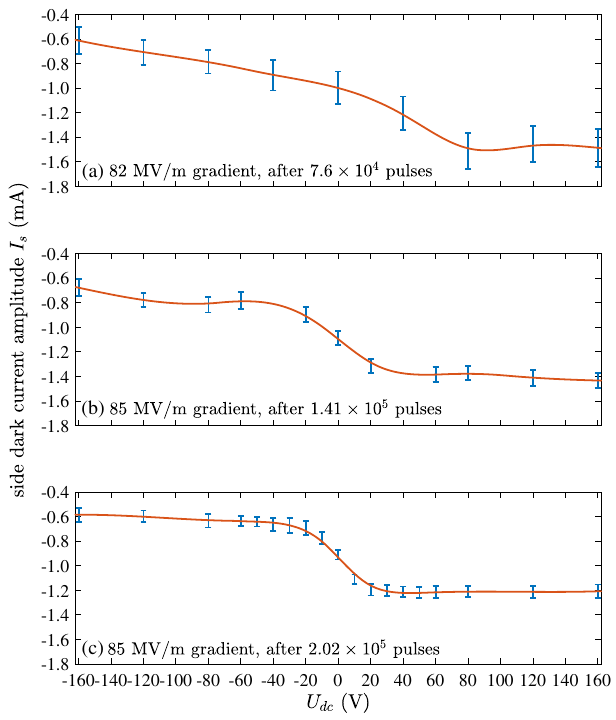
FIG. 15. Measurement results and the spline fitting (visual aid) of the side dark current amplitude under different dc bias voltages applied on the side dark current monitor, (a) after 7 . 6 × 10 4 pulses at 82 MV = m gradient; (b) after 1 . 41 × 10 5 pulses at 85 MV = m gradient; (c) after 2 . 02 × 10 5 pulses at 85 MV = m gradient.